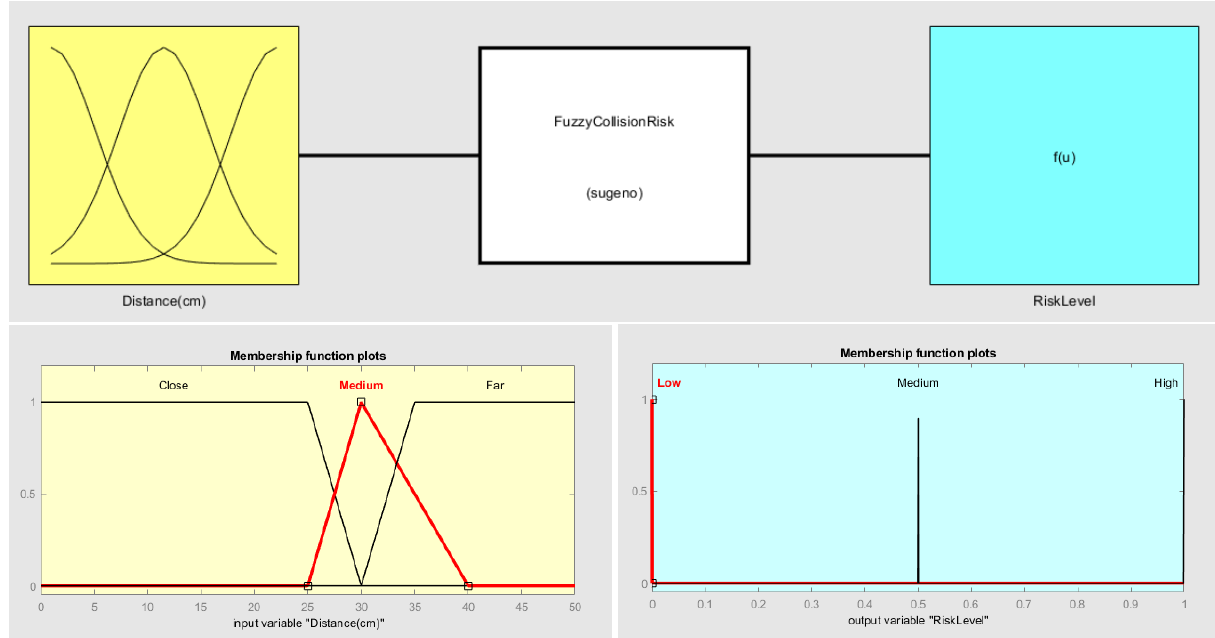
Figure 9. Fuzzy Collision Risk system (from top to left): system blocks with one input ( Distance ) and one output ( RiskLevel ); linguistic terms and membership functions for the input; and singleton values for the output. Given a crisp measurement ( Distance ) of the ultrasonic sensor, the degree of truth of each rule, or weight ( w ( Distance ) ), is evaluated (Fuzzyfication). Since in this case